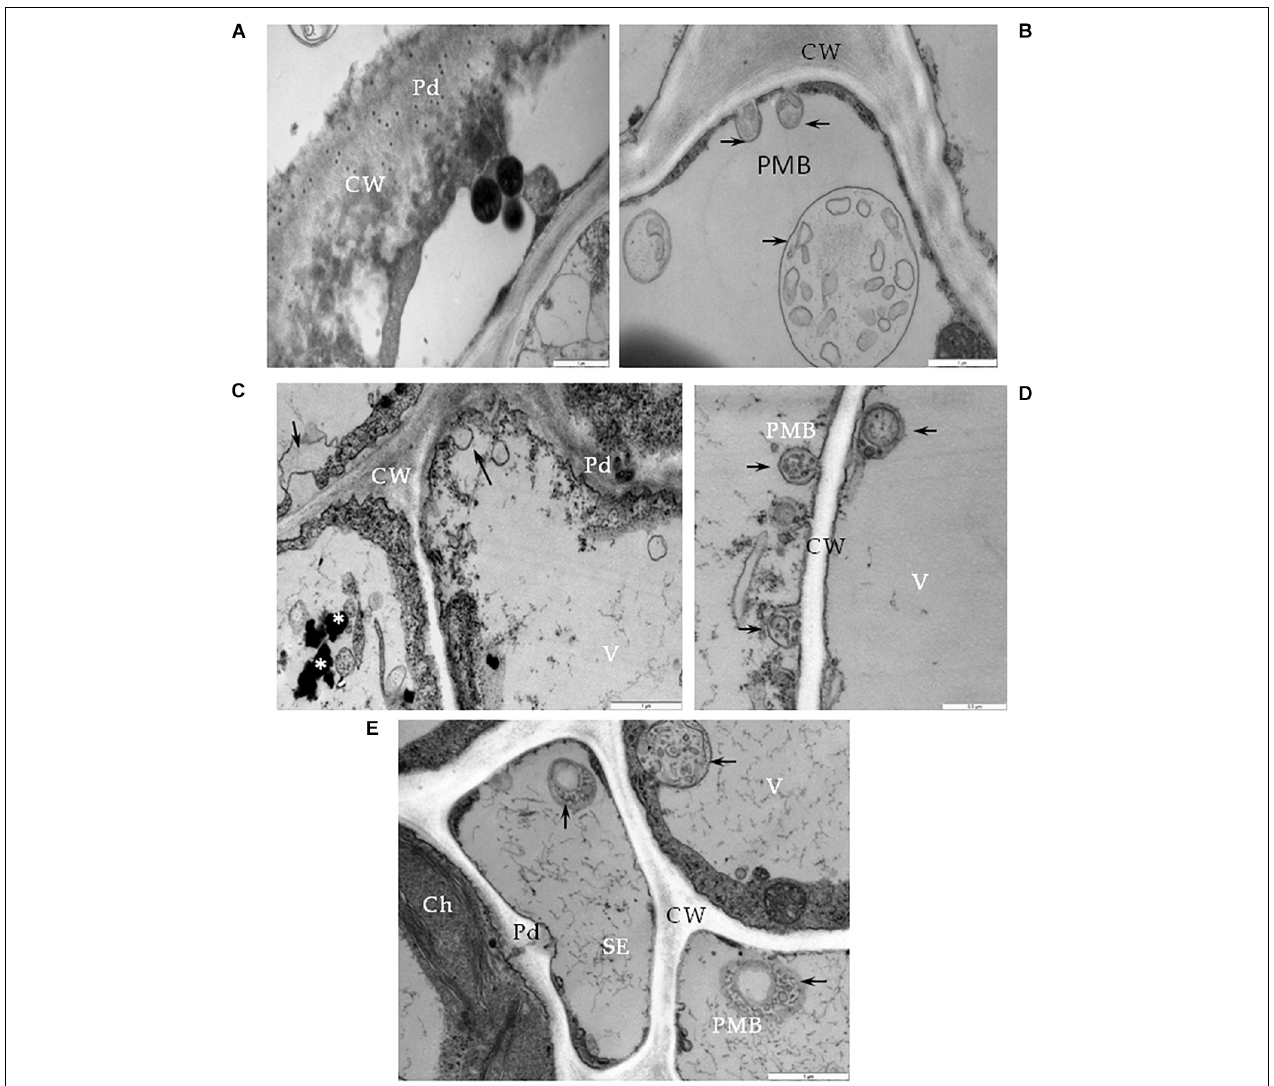
FIGURE 4 | Cell wall alterations in cells of BPEV-infected tissues. (A) Phloem parenchyma (PP) cell wall (CW) loosening in the area near the plasmodesmata (Pd). Bar 1 µ m. (B) Paramular bodies (PMB) formation (arrows) in epidermis cell. CW-cell wall. Bar 1 µ m. (C) Changed cell wall (CW) structure with the formation of paramular bodies (arrows) in phloem parenchyma cells. Vesicular structures around phenolic compounds in vacuole (*). Pd-plasmodesmata. Bar 1 µ m. (D) Paramular bodies (arrows, PMB) between cell wall (CW) and vacuole (V) in mesophyll cells. Bar 0.5 µ m. (E) Paramular bodies (arrows, PMB) in sieve elements (SE) and companion phloem cells. Ch-chloroplast, Pd-plasmodesmata. Bar 1 µ